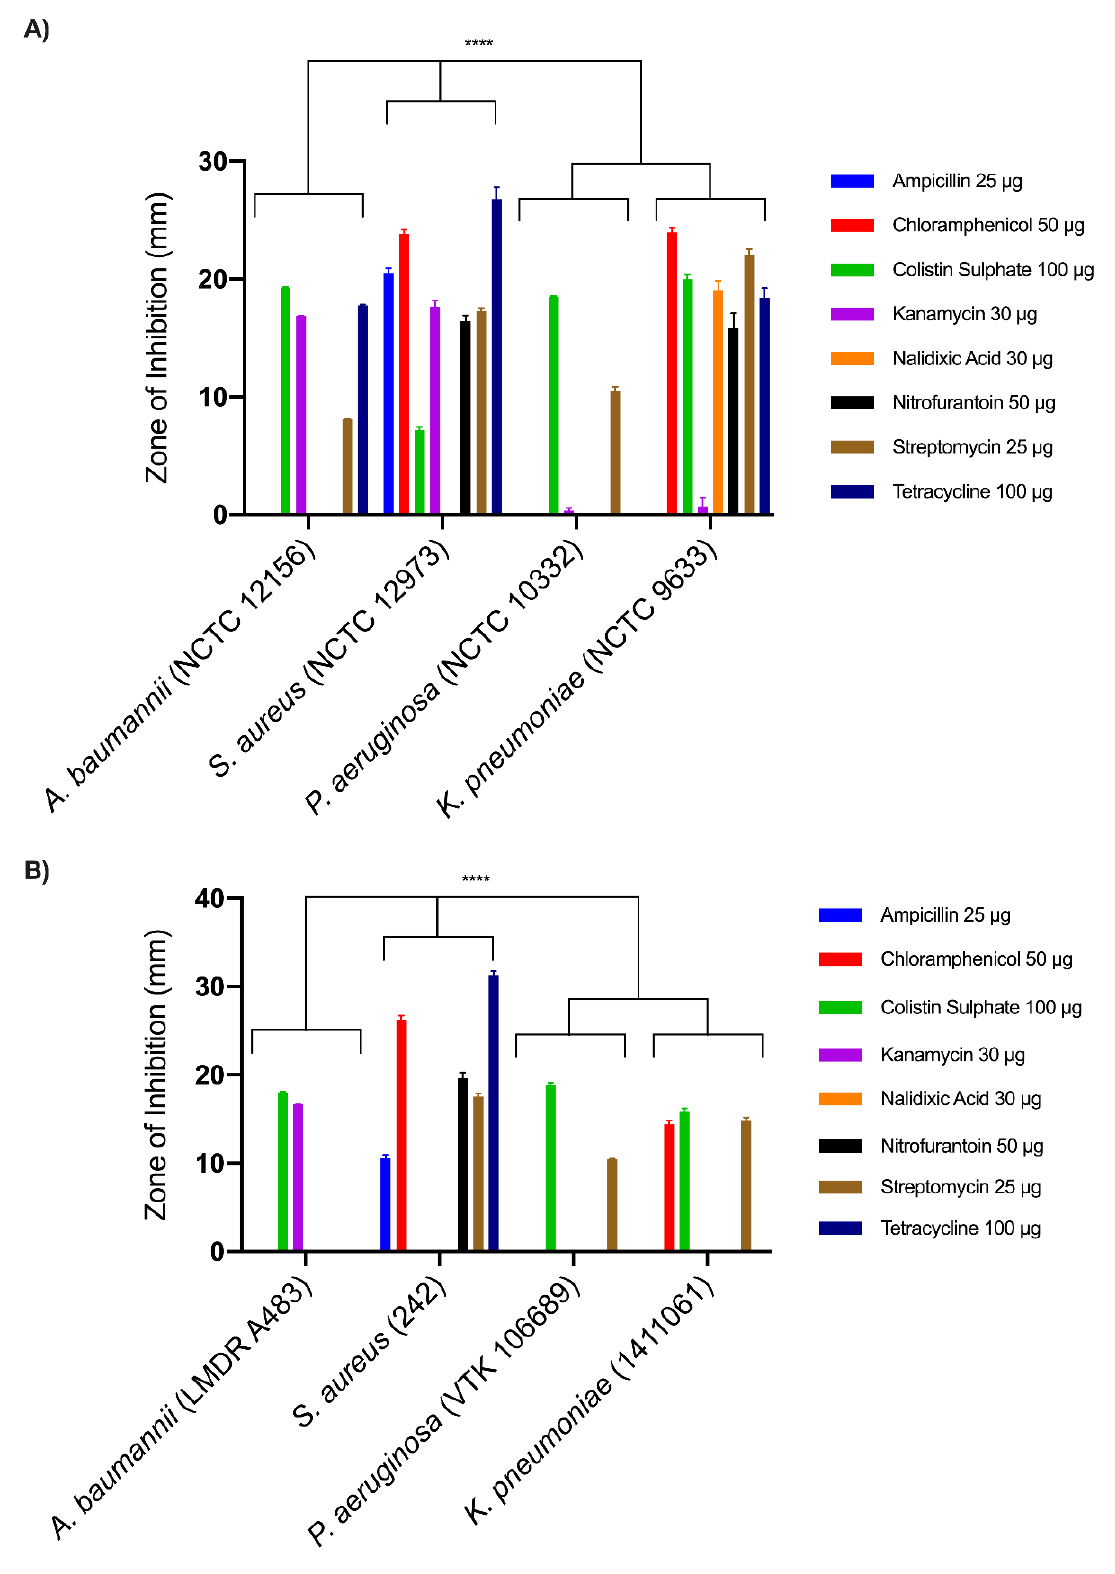
Figure 2. Antimicrobial susceptibility profiles against commonly used antibiotics against Gram-negative bacteria was determined using MASTRING-S ® (M26/NCE) against, ( A ) susceptible bacterial strains and ( B ) resistant bacterial strains ( n = 3) **** p ≤ 0.0001.